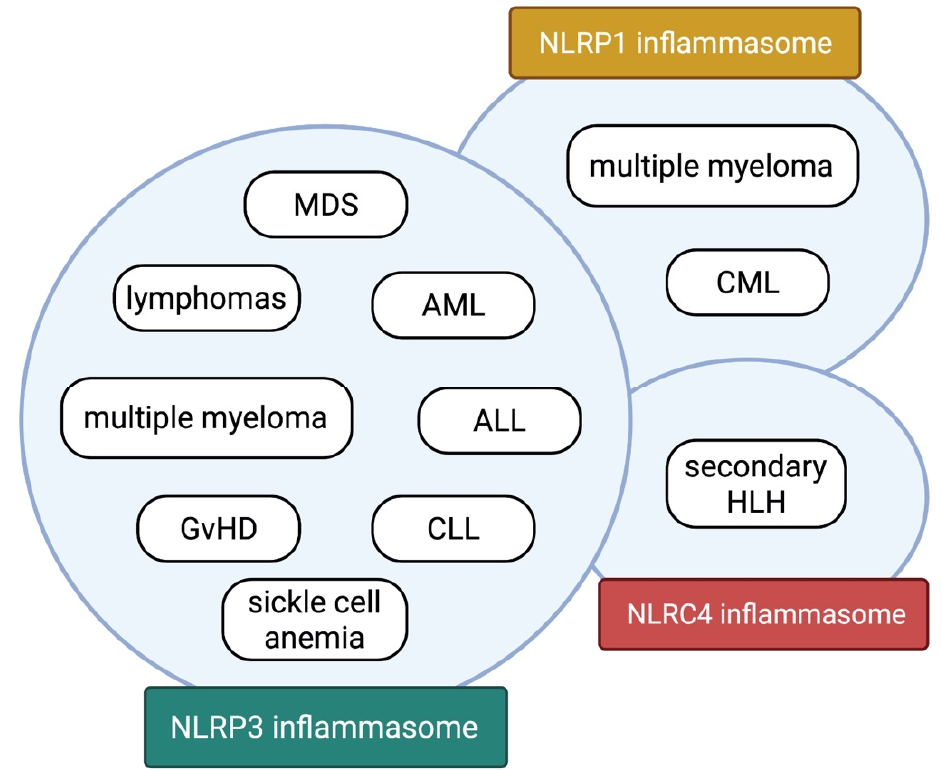
Figure 4. The inflammasomes and their involvement in hematological diseases. The NLRP3 inflam- masome contributes to the pathogenesis of numerous hematological diseases: several lymphomas, multiple myeloma, acute myeloid leukemia (AML), acute lymphoblastic leukemia (ALL), chronic lym- phocytic leukemia (CLL), myelodysplastic neoplasms (MDS), graft versus host disease (GvHD) and sickle cell anemia. The NLRP1 inflammasome contributes to the pathogenesis of multiple myeloma and chronic myeloid leukemia (CML). The NLRC4 inflammasome contributes to the pathogenesis of secondary hemophagocytic lymphohistiocytosis (secondary HLH). Created with BioRender.com (accessed on 10 May 2022).